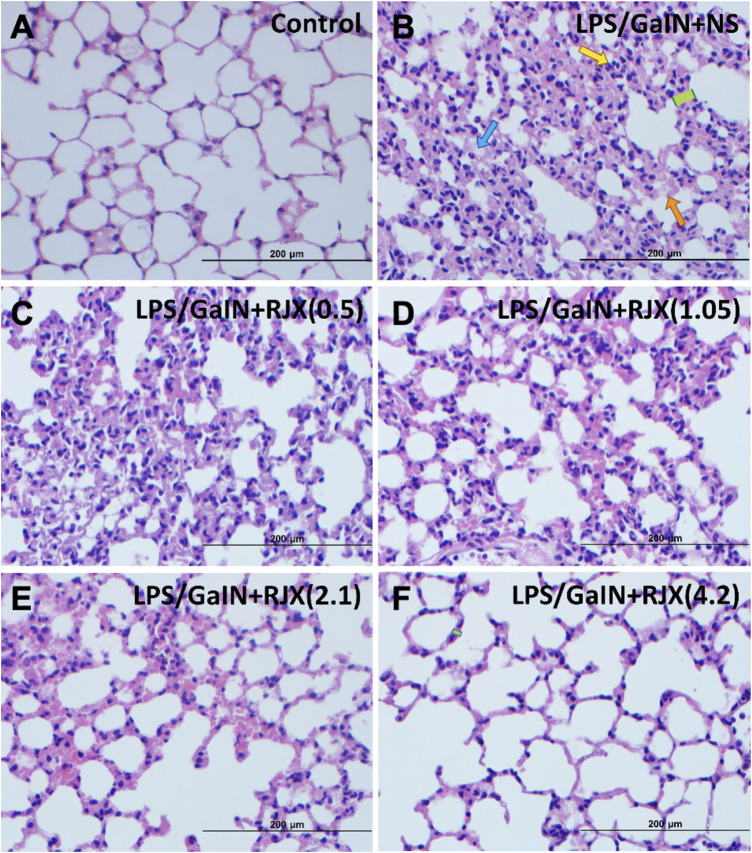
Rejuveinix (RJX) Prevents Acute Lung Injury and Inflammation in the Lipopolysaccharide-Galactosamine (LPS-GalN) Mouse Model of acute respiratory distress syndrome (ARDS) and Multi-organ Failure. Mice were treated with i.p injections of RJX (0.5, 1.05, 2.1, 4.2 ml/kg, 0.5 ml/mouse) or normal saline (NS) 2 h before and 2 h post-injection of LPS-GalN. Except for untreated mice (Control), each mouse received 0.5 ml of LPS-GalN (consisting of 100 ng of LPS plus 8 mg of D-galactosamine) i.p. The RJX dose levels (in ml/kg) are indicated in parentheses. Yellow arrow: inflammatory cell infiltration; Blue arrow: Exudate; Orange arrow: hemorrhage; Green block: thickness of alveolar wall. Panel B: Blue arrow: Exudate (see B1 of
Supplementary Figure S7
 for an enlarged inset); Yellow arrow: inflammatory cell infiltration (see B2 of
Supplementary Figure S7
 for an enlarged inset); Green block: thickness of alveolar wall (see B3 of
Supplementary Figure S7
 for an enlarged inset). Orange arrow: hemorrhage (see B4 of
Supplementary Figure S7
 for an enlarged inset); H&E ×400.